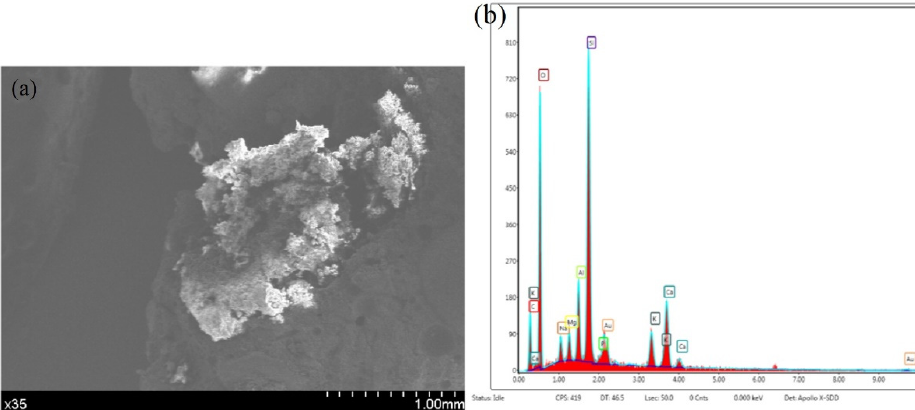
Figure 9. The micromorphology and EDS composition of the sample after healing. ( a ) Micromorphology. ( b ) EDS results.